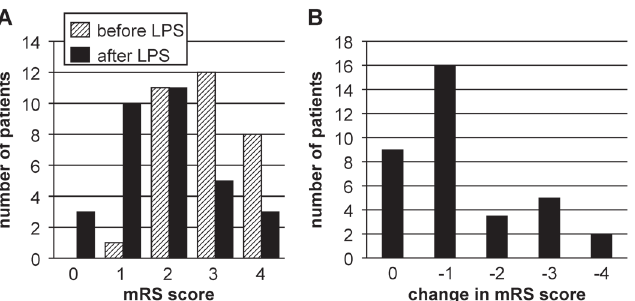
Fig 1. Bar charts of patient functional status based on their mRS score. A: Distribution of patients across mRS scores before and after LPS. B: Change in the median mRS scores 1 year after LPS. Abbreviations: LPS, lumboperitoneal shunting; mRS, modified Rankin Scale.